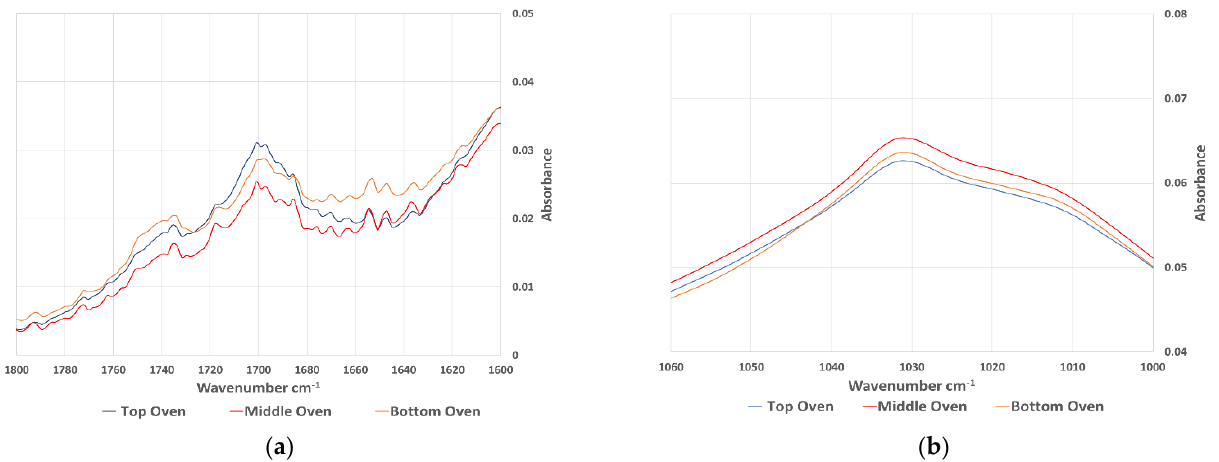
Figure 8. The ( a ) carbonyl and ( b ) sulfoxide peaks from FT-IR spectra of samples aged in the oven.